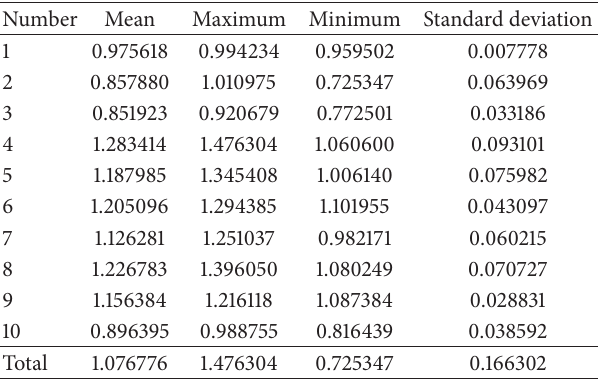
Table 4: The descriptive statistics of time-varying beta of large corporations.